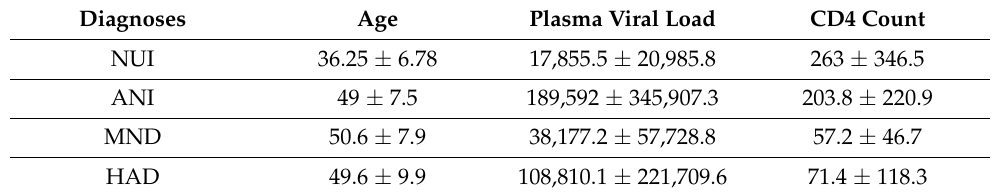
Table 2. Mean of clinical characteristics: Mean and standard deviation of age, plasma viral load, and CD4+ cell count were calculated for the four groups: NUI, ANI, MND, and HAD.